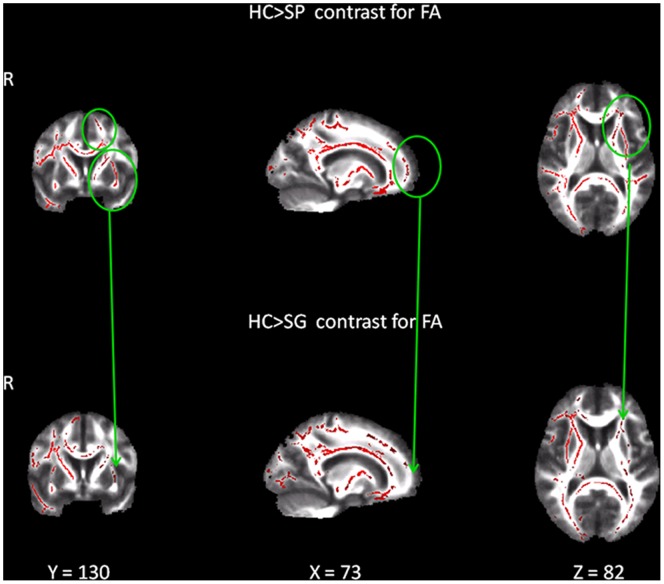
Significant changes in FA for the stroke group with poor recovery (SP) and the stroke group with good recovery (SG) at 3 months when compared with healthy controls (HC).The red color identifies clusters with significant decrease of FA. Statistical maps are represented in radiological convention (right corresponds to left hemisphere), superimposed on an MNI152 template. The threshold for significance was set at p≤0.02 corrected for multiple comparisons. Circles highlight the locus of clusters in the HC>SP contrasts not found in the HC> SG contrast.